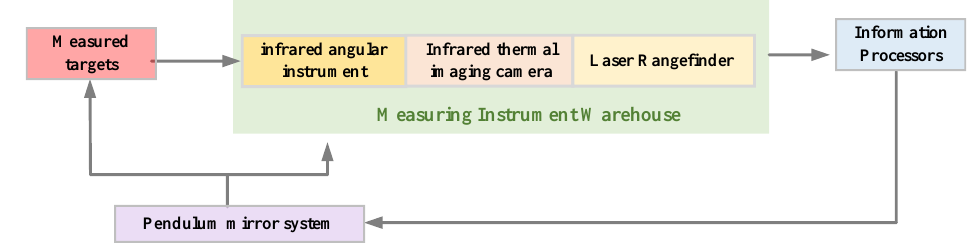
Figure 29. Schematic diagram of laser + infrared composite measurement.